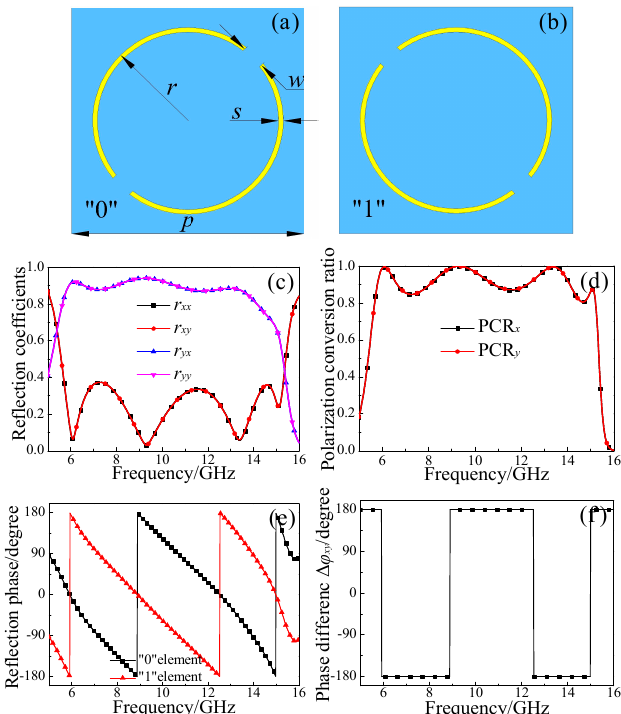
Figure 2. ( a ) Basic unit “0”; ( b ) basic unit “1”; ( c ) the reflection coefficients of “0” and “1”; ( d ) the linear polarization conversion ratio for the normal incident x - and y -polarized wave; ( e ) the cross-polarization phase of “0” and “1”; and ( f ) the cross-polarization phase difference of “0” and “1”.